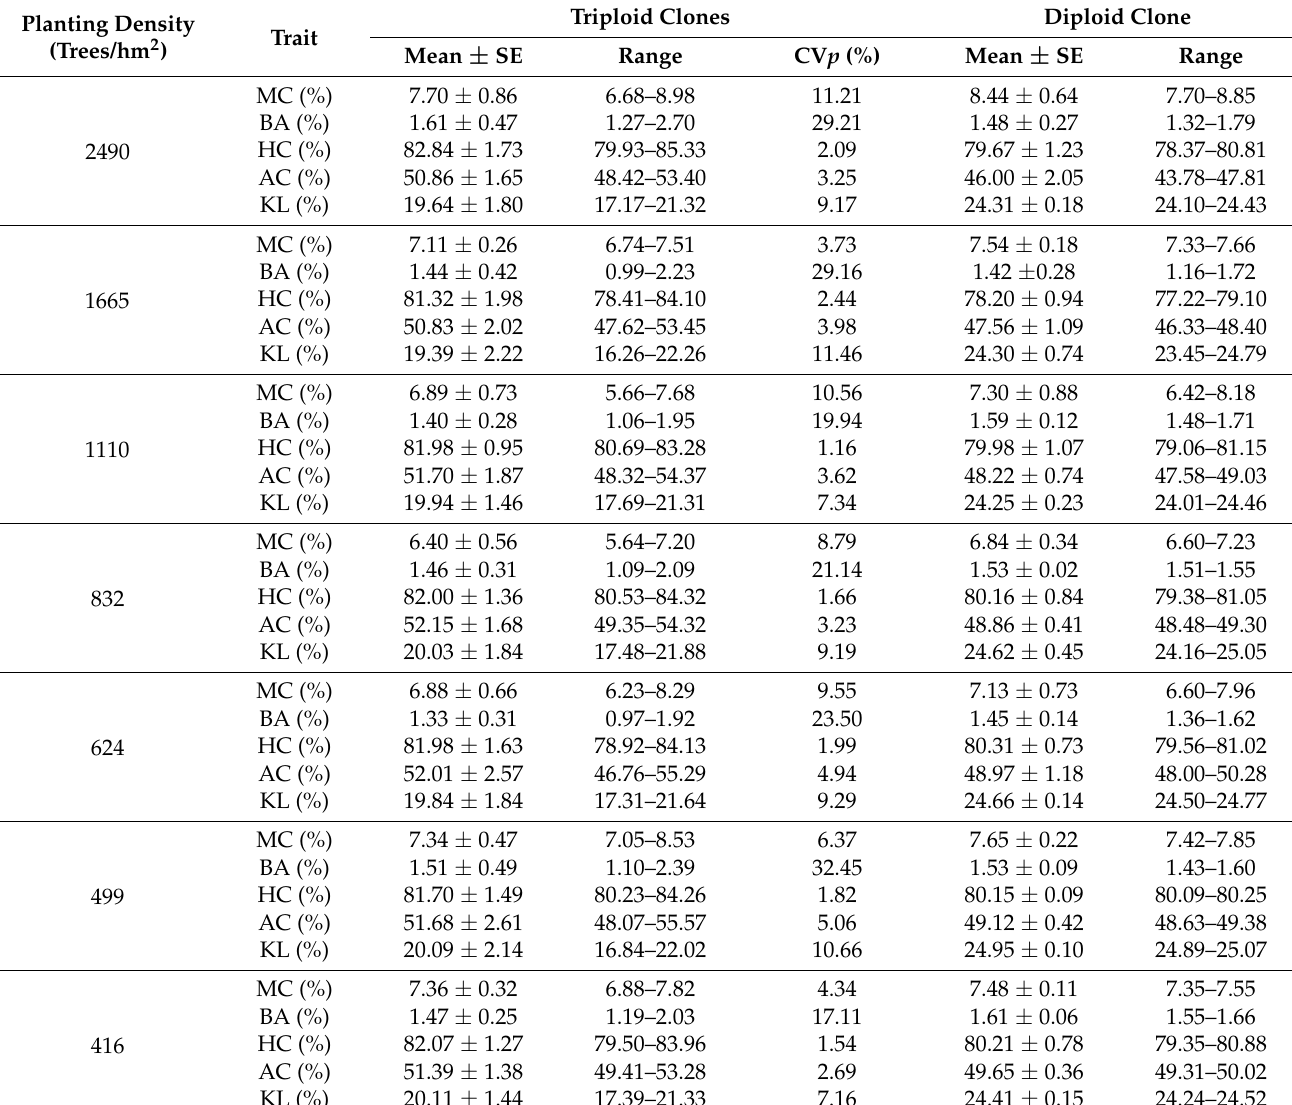
Table 2. Clone means ( ± SE), variation range, and phenotypic variation coefficients (CV p %) of moisture content and chemical compositions at seven initial planting